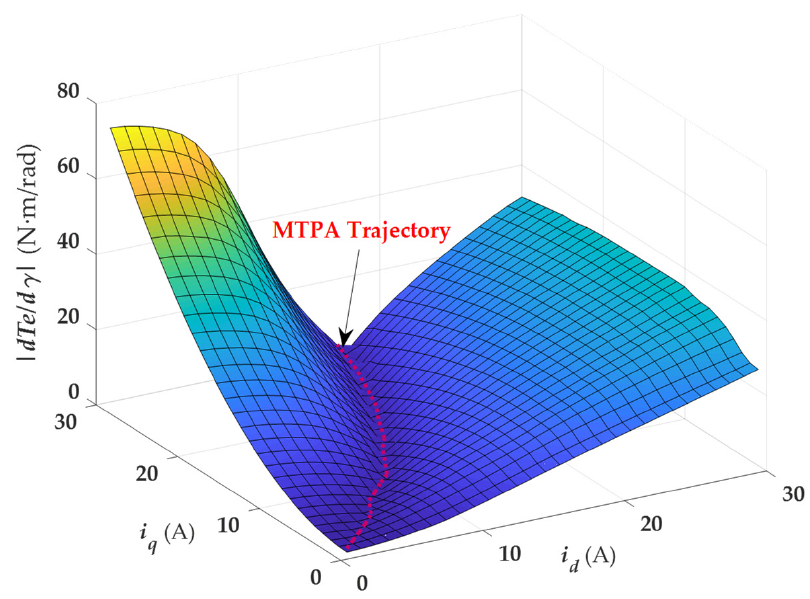
( b ) Figure 4. The MTPA trajectories that were calculated by considering the nonlinear characteristics: ( a ) current–angle trajec- tory and ( b ) torque–flux linkage trajectory. 3. Proposed MPTC Method with Duty Cycle Optimization The overall control diagram of the proposed MPTC method based on MTPA is shown in Figure 4 and is mainly composed of the following parts: the MPTC module, the external speed control loop, the coordinate transformation, the flux linkage and torque estima- tions, the inductance estimations, and the pulse generation. The torque reference